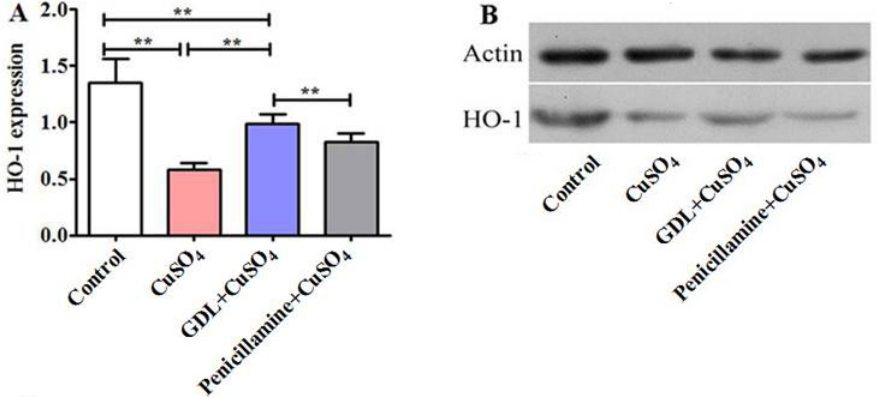
Figure 6. Effect of HO-1 protein in the heart tissue after different treatments ( A ). HO-1 and Action ( B ). Data are presented as mean ± SEM ( n = 10). ** p < 0.01.